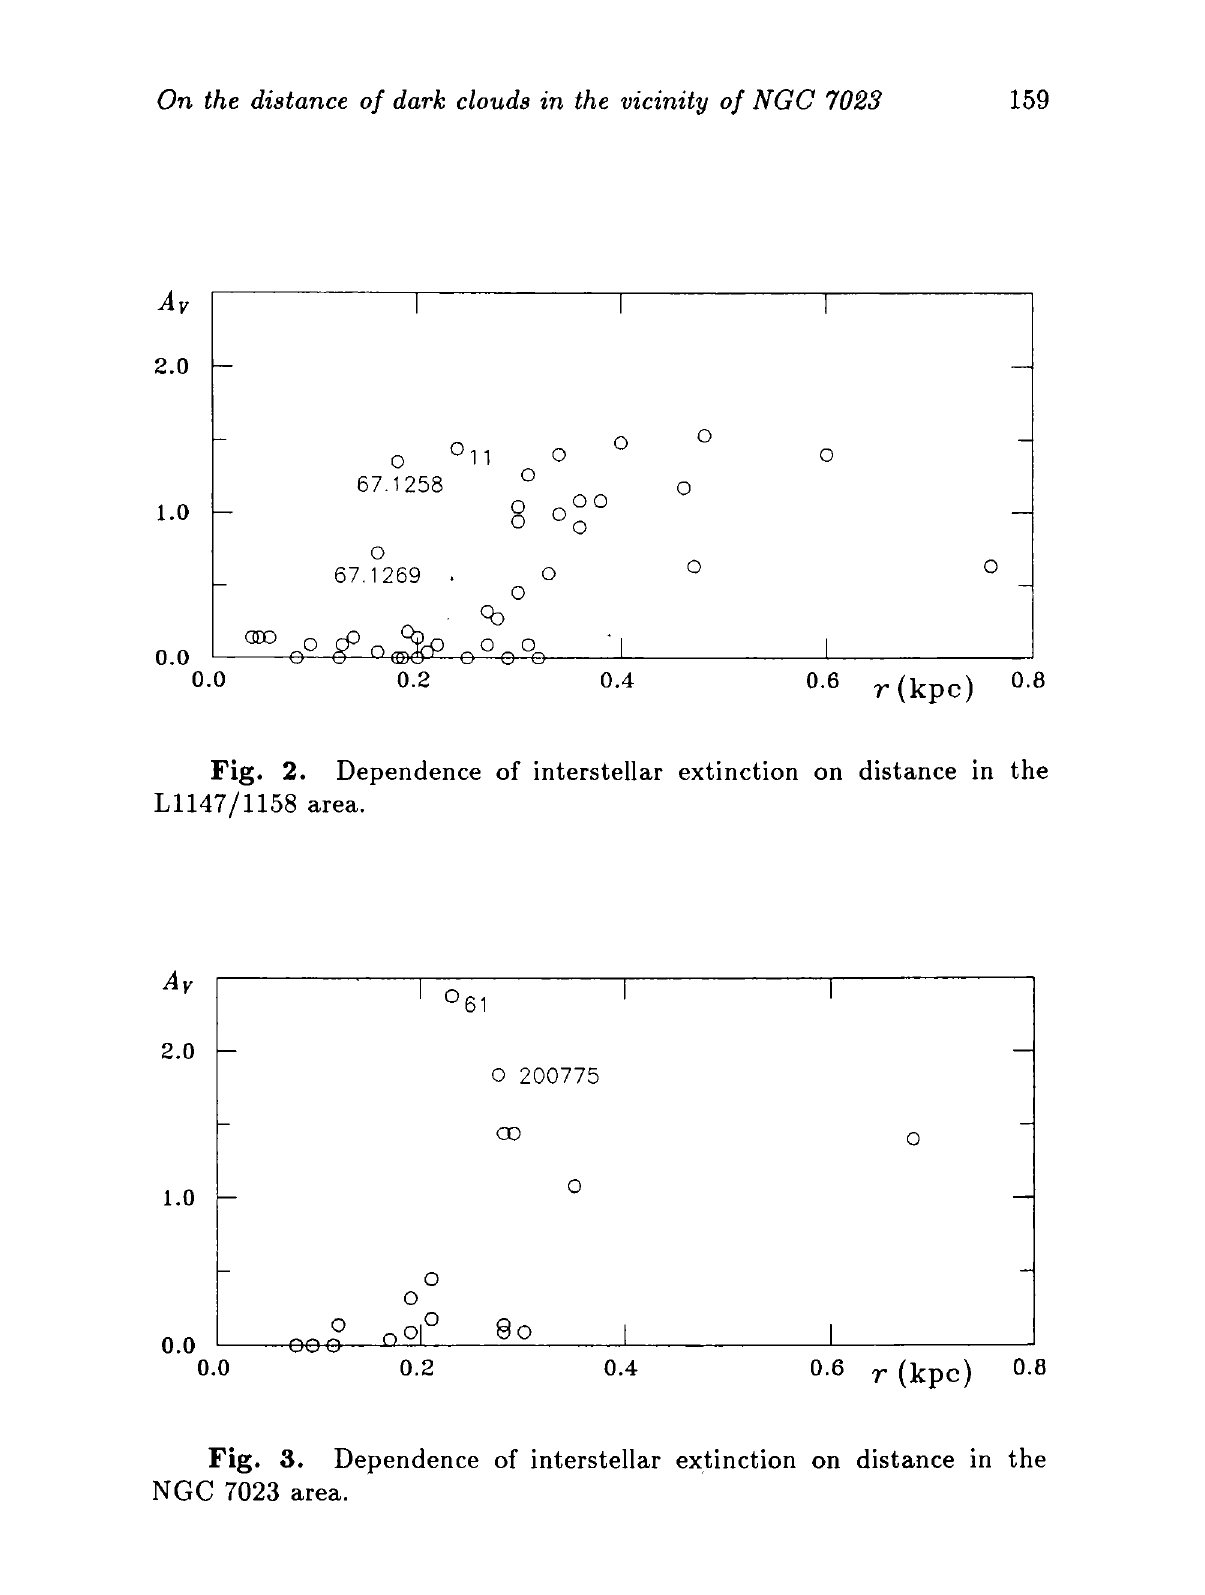
Fig. 3. Dependence of interstellar extinction on distance in the NGC 7023